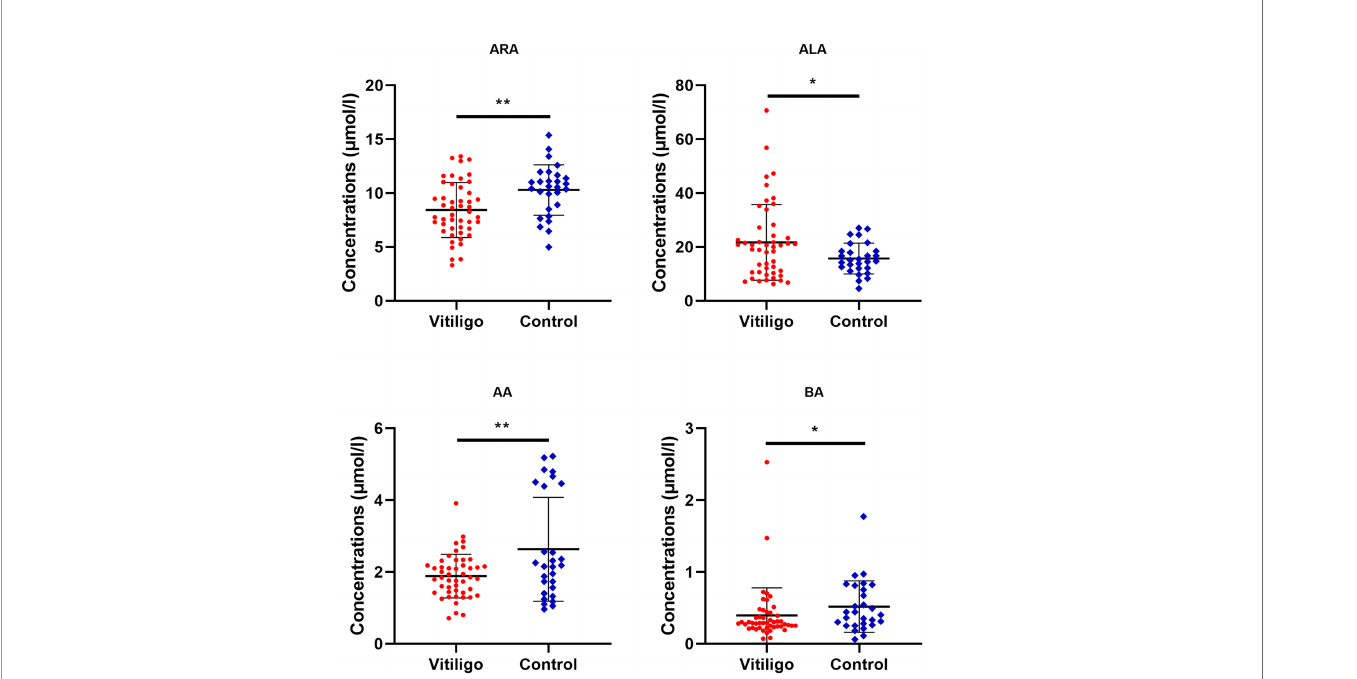
FIGURE 2 | Differential fatty acid levels in vitiligo patients as compared to healthy controls. The levels of ARA, ALA, AA and BA in vitiligo patients or healthy individuals were compared. The mean and standard deviation were represented by middle black line, the lower and upper black lines, respectively. ARA, arachidonic acid; ALA, alpha-linolenic acid; AA, arachidic acid; BA, behenic acid. * P < 0.05, ** P <